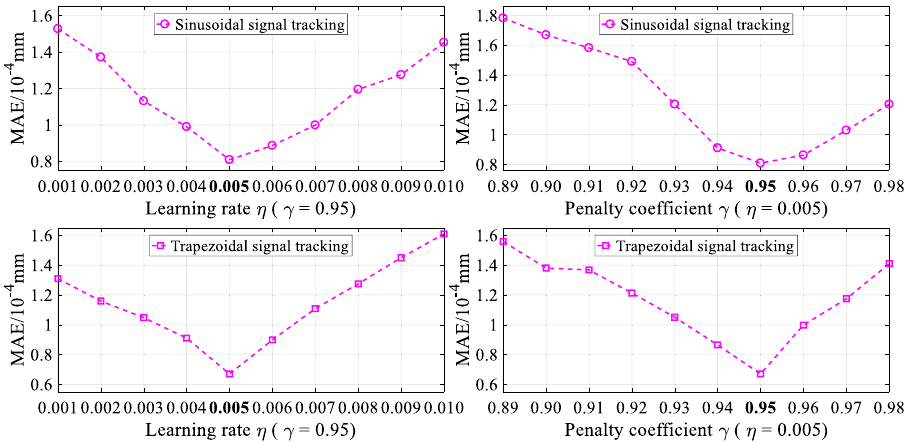
Figure 4. Simulation results of the RNN-based hybrid controller under different hyper-parameters.